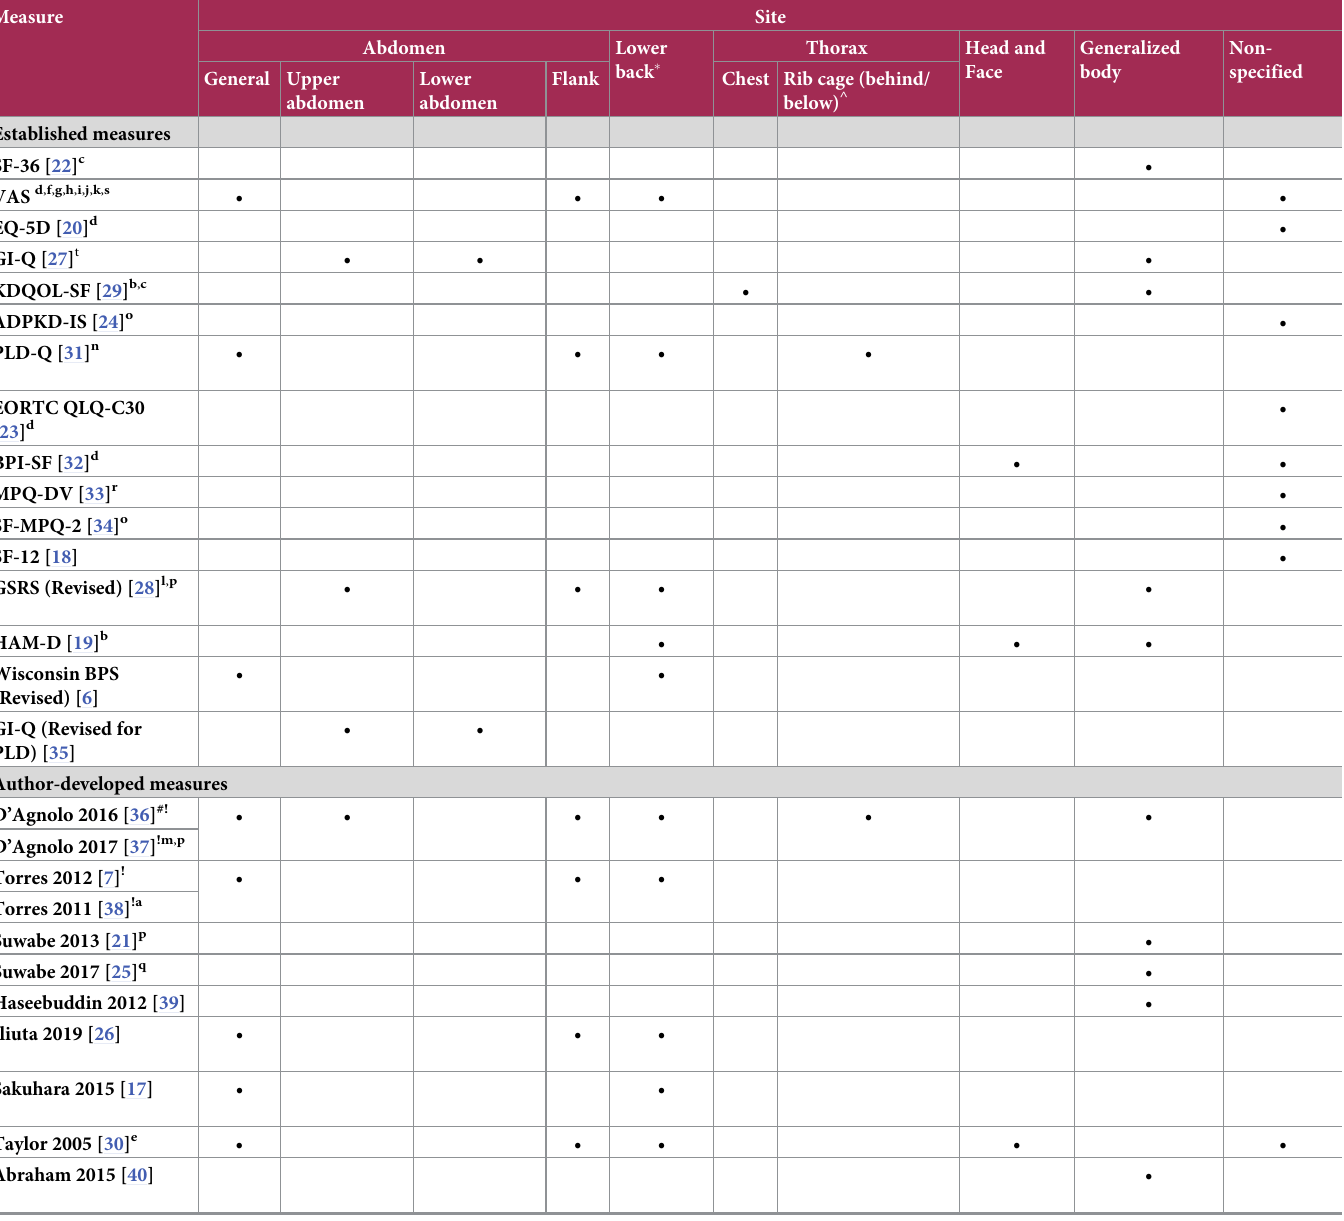
Table 2. Dimensions of pain assessed by measures: Site of